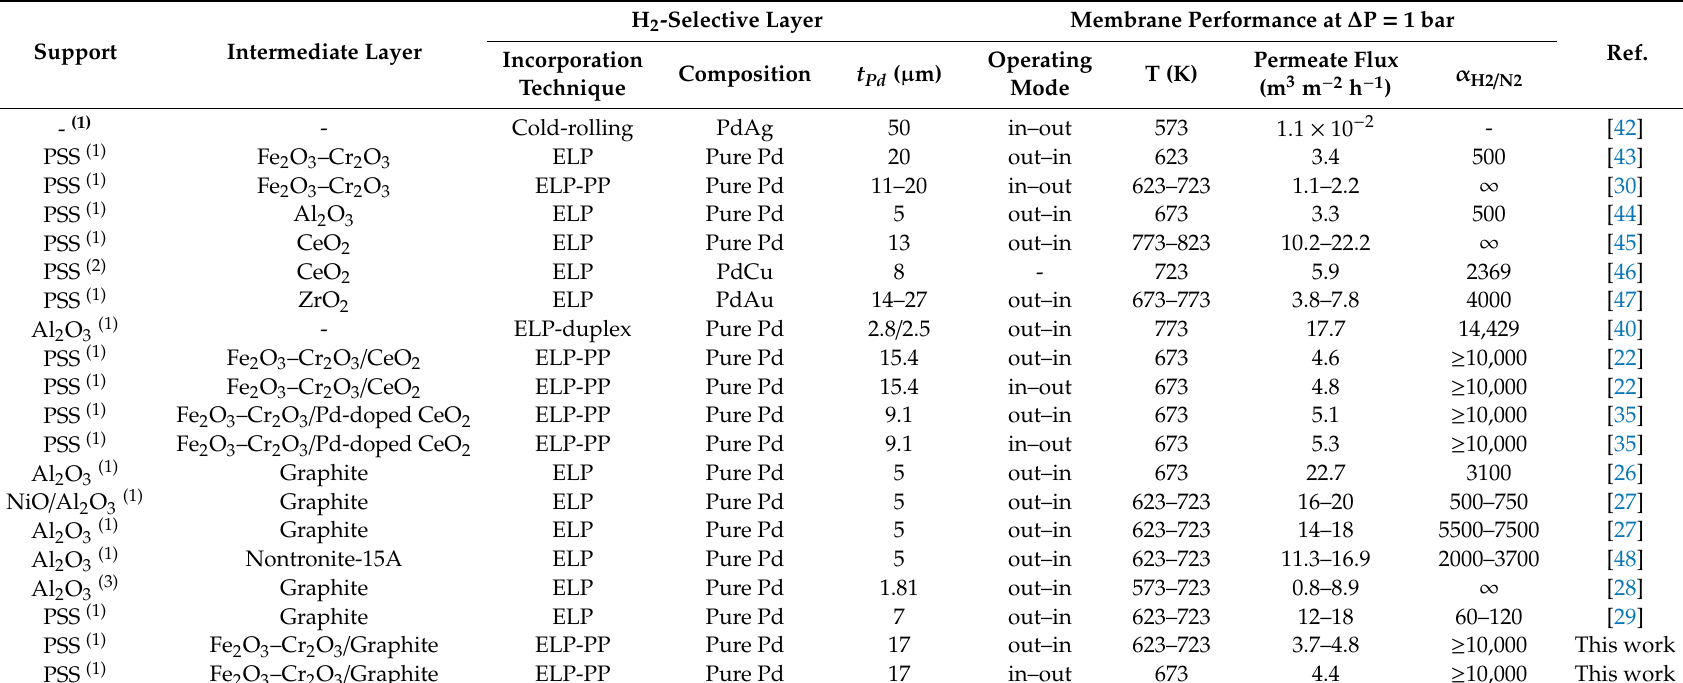
Table 1. Comparison of main characteristics and performance for relevant membranes in